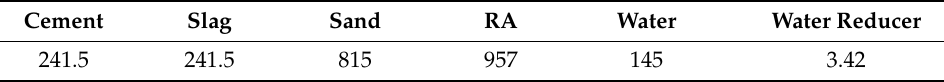
Table 2. Mix proportion of RAC (kg/m 3 ).